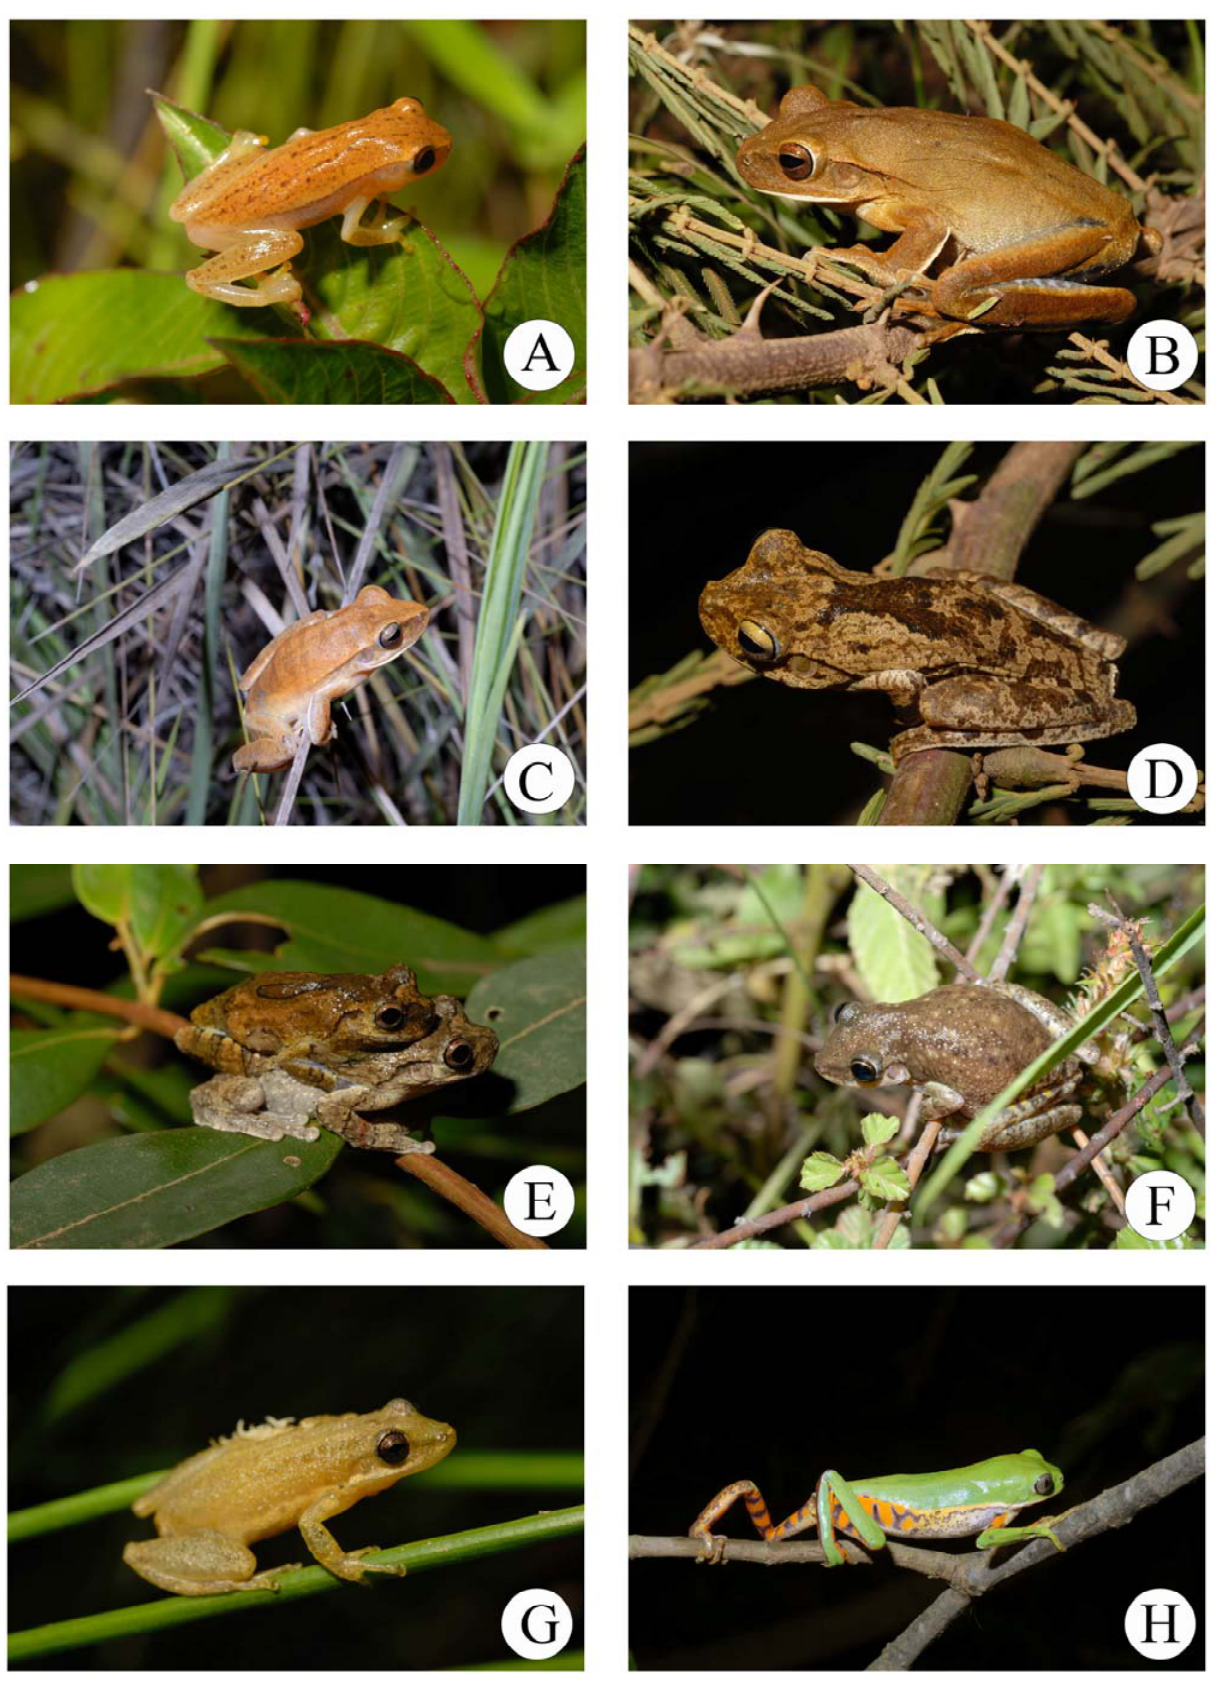
Figure 5. Hylid species collected in the municipality of São Desidério, state of Bahia. A. Dendropsophus nanus ; B. Hypsiboas raniceps ; C. Hypsiboas albopunctatus ; D. Hypsiboas crepitans ; E. Dendropsophus melanargyreus ; F. Scinax sp. gr . ruber ; G. Scinax fuscomarginatus ; H. Phyllomedusa azurea . Photo: P. H.